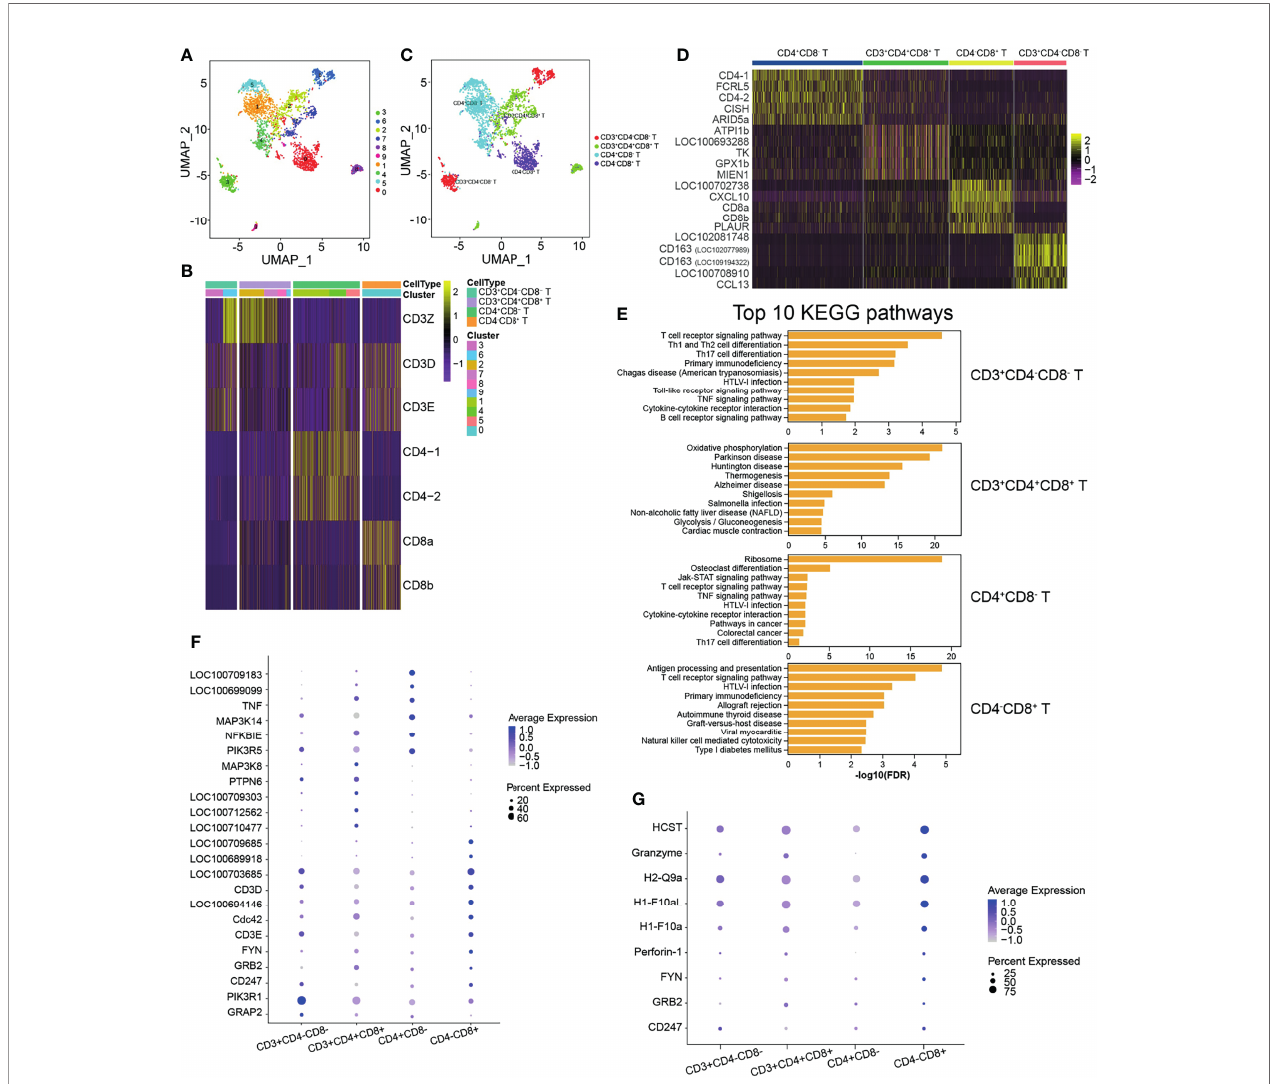
FIGURE 4 | Heterogeneous subsets in T cells. (A) The identi fi ed whole T cells were classi fi ed into 10 clusters and shown with a uniform manifold approximation and projection (UMP) space. The clusters were obtained with a resolution of 0.5. (B) Heatmap of the different expressions of the genes used to identify the T-cell subsets. T cells were identi fi ed into four T-cell subsets: CD3 + CD4 − CD8 − , CD3 + CD4 + CD8 + , CD4 + CD8 − , and CD4 − CD8 + . (C) Distribution of the identi fi ed T-cell subsets in UMAP space. (D) Heatmap of the top 5 most signi fi cantly expressed genes for each T-cell subset. (E) The top 10 most signi fi cant Kyoto Encyclopedia of Genes and Genomes (KEGG) pathways for each T-cell subset. (F) Bubble chart of the related genes in the enriched pathway of T-cell receptor signaling in T-cell subsets. (G) Bubble chart of the related genes in the enriched pathway of natural killer cell-mediated cytotoxicity in T-cell